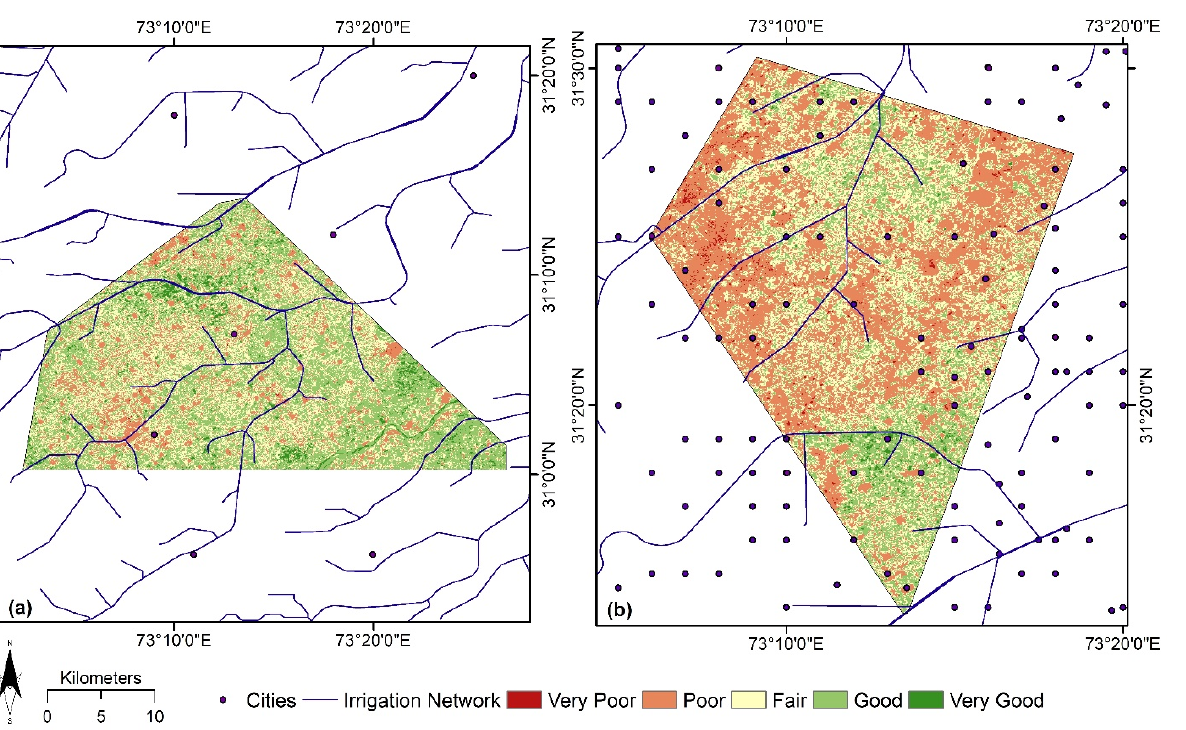
Figure 11. Irrigation network of the best and worst area. ( a ) water bodies in Tandlian Wala Town ( b ) irrigation network in Madina and Lyallpur towns.